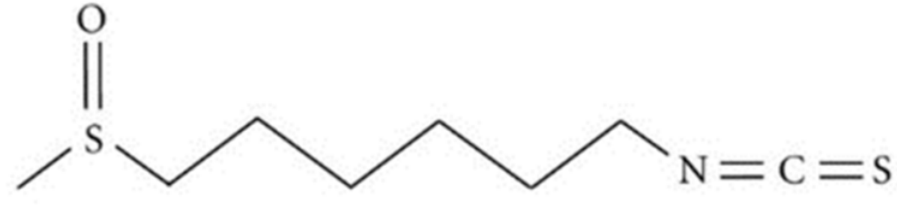
Figure 1. Chemical structure of 6 ‐ (methylsulfinyl)hexyl isothiocyanate (6 ‐ MSITC).